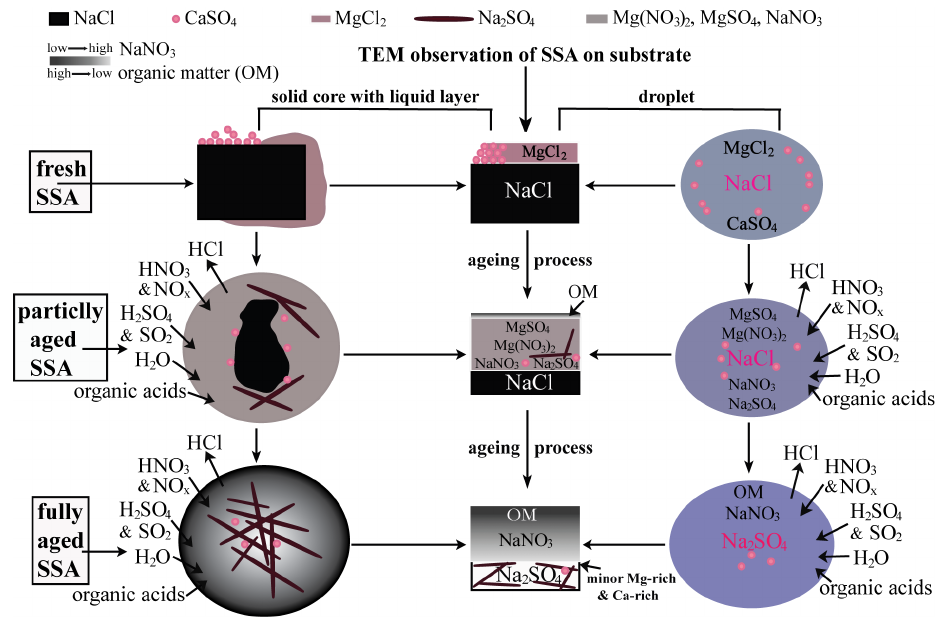
Figure 10. The conceptual model based on our study summarizing the possible SSA ageing processes from fresh, partially aged, and fully aged SSA. Deliquescence RH (DRH) of NaCl is at 75%. SSA ageing could have different processes before and after the